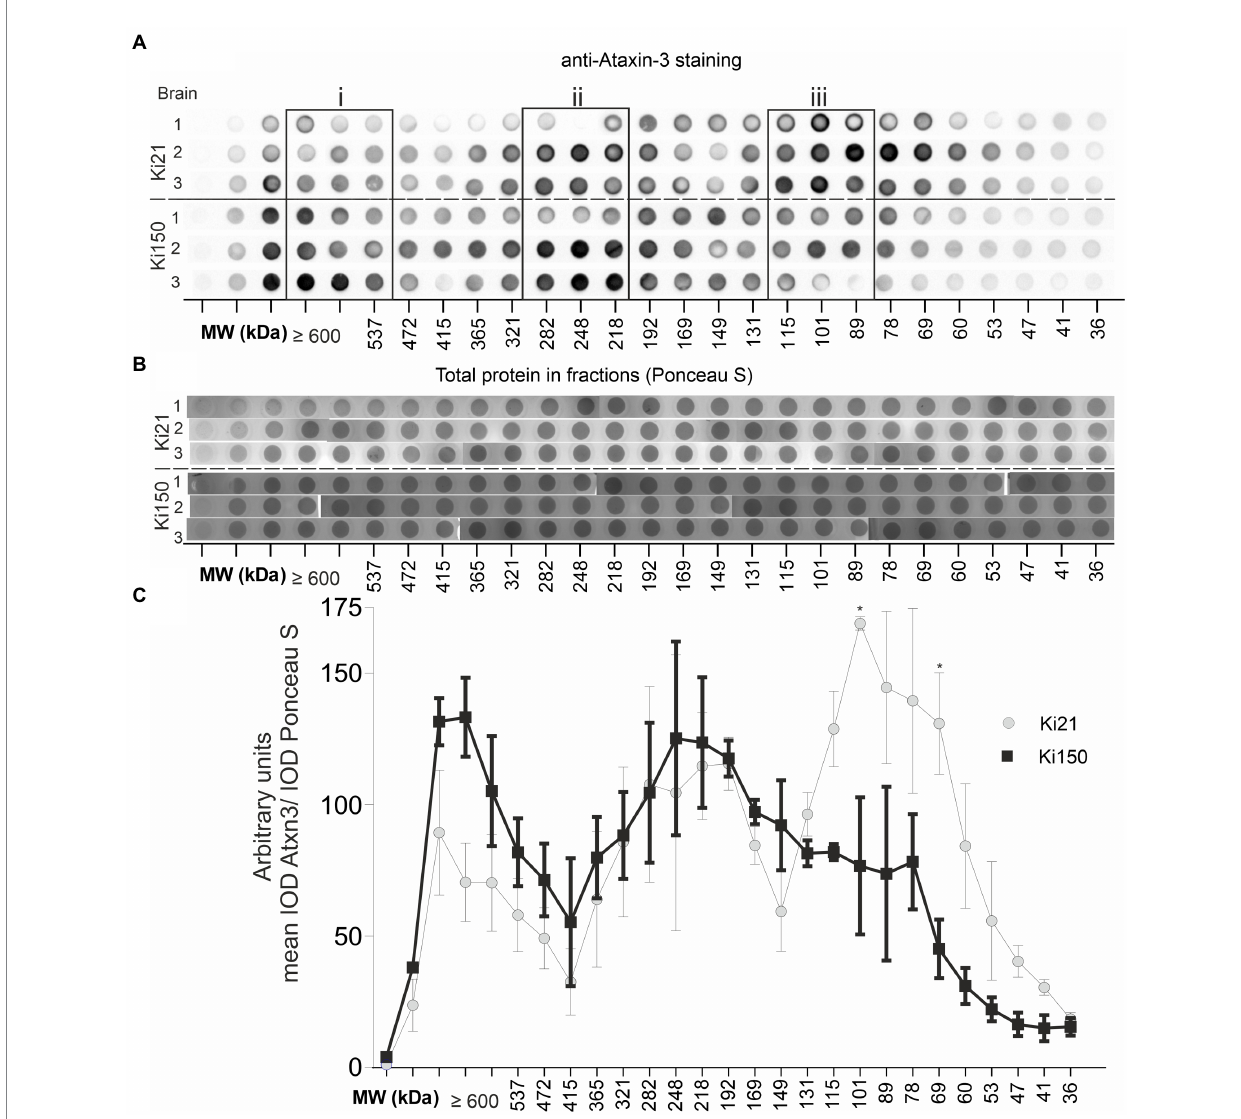
FIGURE 4 Ataxin-3 is distributied in large protein complexes after chromatographic fractionation. (A) Whole brain lysates after fractionation using size exclusion chromatography (SEC). Protein complexes were separated on the basis of their size (in the range of 600–22 kDa) and divided into 31 fractions. Dot blots were probed with an anti-ataxin-3 antibody. The signal indicates the distribution of ataxin-3 among the fractions of the protein complexes in Ki21 and Ki150 protein complexes. (B) Ponceau-stained vacuum dot blot of protein fractions corresponding to the size range >600–22 kDa. (C) Based on the dot blot results, we can distinguish 3 peaks; the first (>600 kDa), the second (248–192 kDa), and the third (115-89 kDa). In the third peak (115–89 kDa) the level of mutant ataxin-3 in Ki150 brains is significantly lower than in the control Ki21 brain lysates. Two-sample t -test (* p < 0.05, ** p < 0.01, *** p < 0.001), error bars: SEM total number of biological replicates: n = 6, n = 3 per